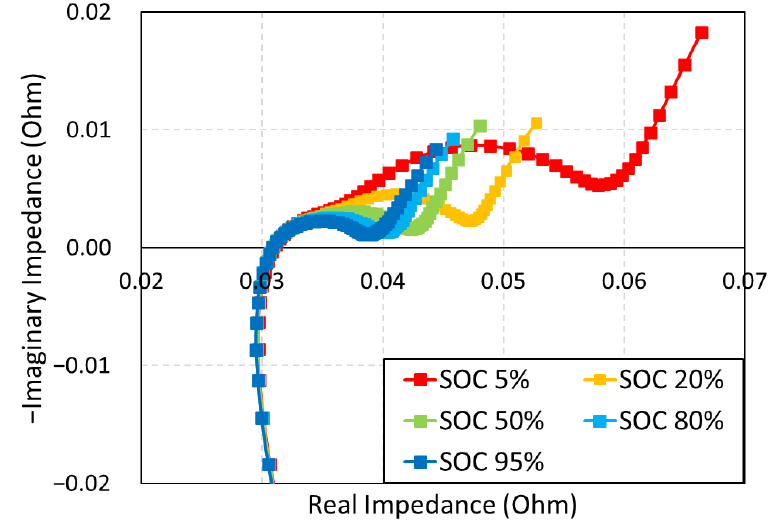
Figure 9. EIS measurements in a fresh cell at 5, 10, 15, 20 and 25% SOC.